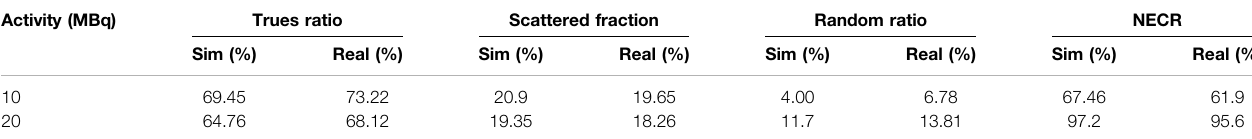
TABLE 1 | Measured and simulated trues, scattered and randoms fraction for two activities. Activity (MBq) Scattered